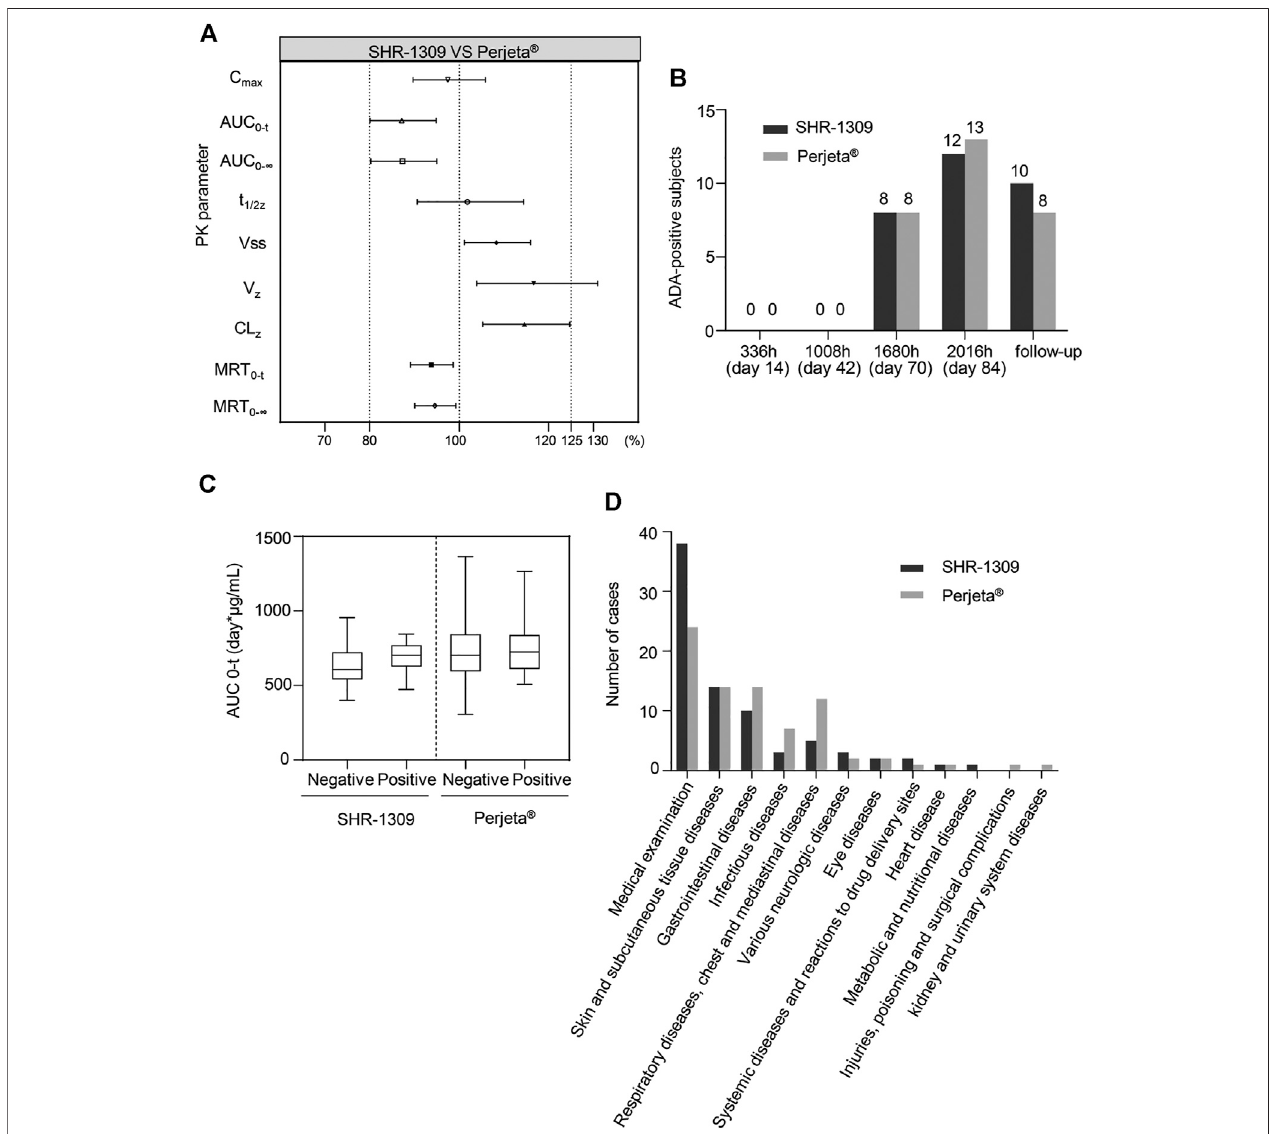
FIGURE 3 | Bioequivalence,immunogenicityandsafetyanalysisofSHR1309andPerjeta ® . (A) Under90%CI,thegeometricratiorangesofPKparametersforSHR1309 and Perjeta ® . PK: pharmacokinetic. (B) After intravenous drip of SHR1309 or Perjeta ® , the number of ADA-positive subjects at four different time points (336, 1008, 1680, and 2016 h) and at follow-up time was analyzed. (C) Comparison of AUC values for ADA-positive and -negative subjects in SHR1309 and Perjeta ® , respectively. ADA: antidrug antibody. AUC 0-t :theAUCoftheanalyteintheplasmaover thetimeintervalfromtimezerotothelast measurableconcentration.Thesolid linein themiddlerepresents the median. (D) The TEAE of thetwo groups was categorized according to system organ, and the corresponding cases were quanti fi ed. TEAE: treatment-emergent adverse event.